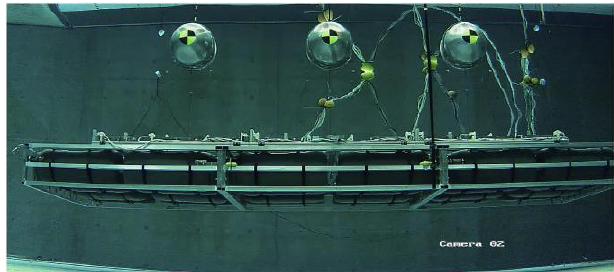
Fig. 1: 1:25 scale model of a multifloat configuration of the WaveSub device during experimental campaign in 2017